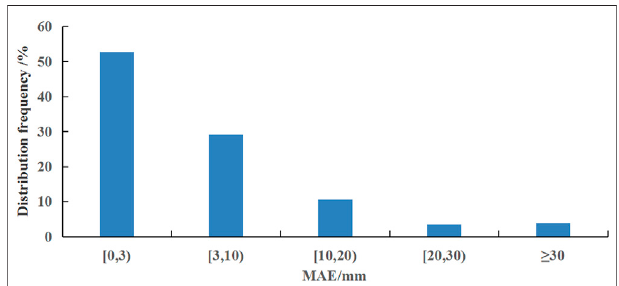
FIGURE4| FrequencydistributionoftheMAEfortheclimatologyvalues.